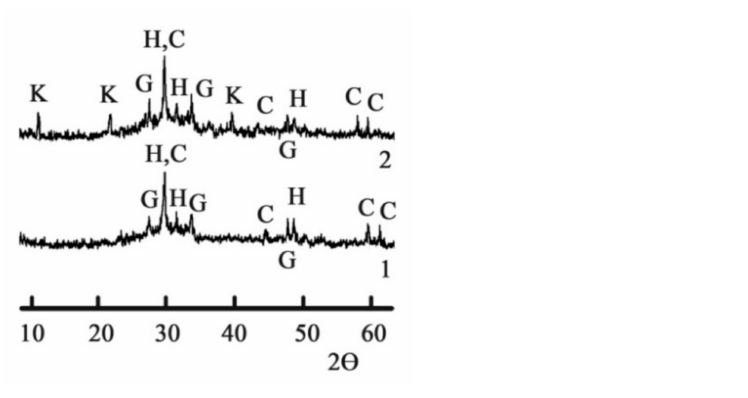
Figure 2. The XRD of the 180-day hydrated blast furnace cement mixed with sea water and containing,